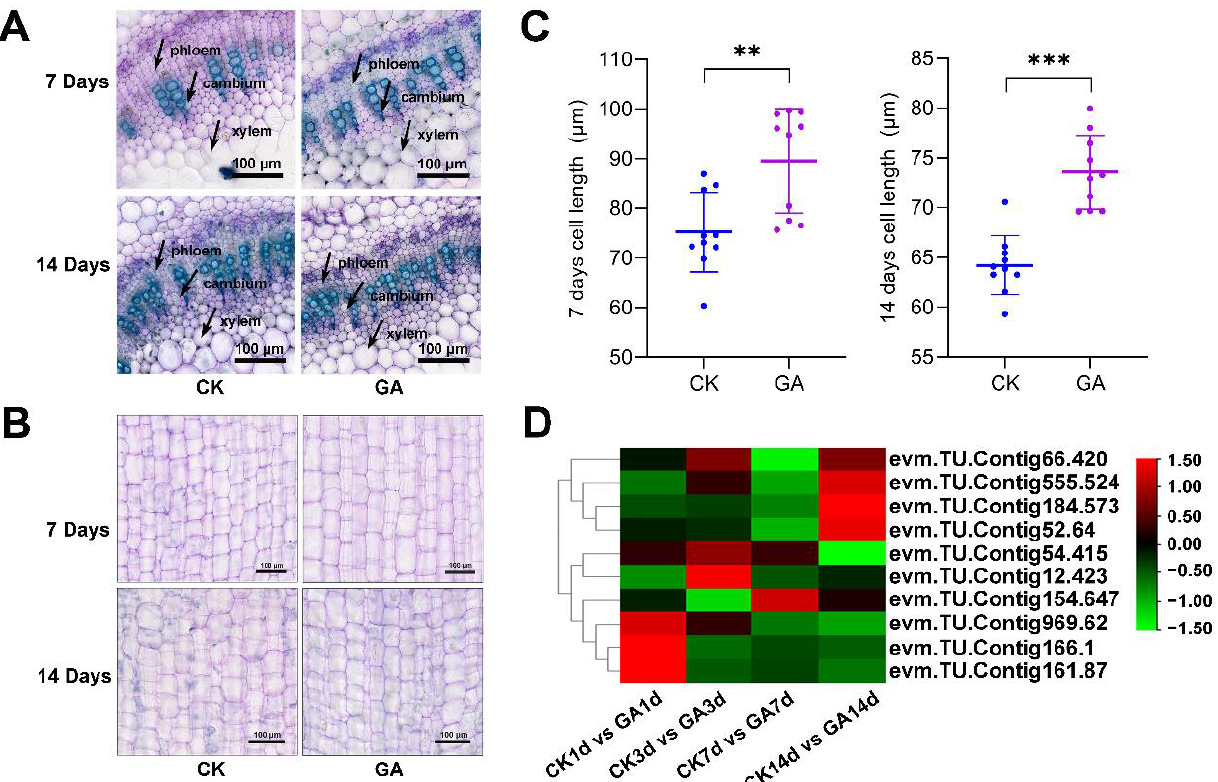
Figure 3. Effects of GA treatment on the second internode of N. cadamba . ( A ) Cross-section analysis of the second internode cell from CK group and GA group at 7 d and 14 d, material stained with toluidine blue. Arrows indicate phloem, cambium, and xylem. Scale bar, 100 µ m. ( B ) Longitudinal section of the second internode cell from CK group and GA group at 7 d and 14 d. Material stained with toluidine blue. Scale bar, 100 µ m. ( C ) The second internode cell length analysis from the CK group and GA groups at 7 d and 14 d. n = 15 and data are mean ± SD of three biological replicates as shown. Differences between mean values of CK and GA were compared using student’s t -test (** and *** denote significant differences at p < 0.01 and 0.001). ( D ) DEGs related to cell elongation were analyzed from RNA-seq data. Data are shown with log2 (Fold Change) analysis. Rows and columns of heatmap represent genes and samples, respectively.